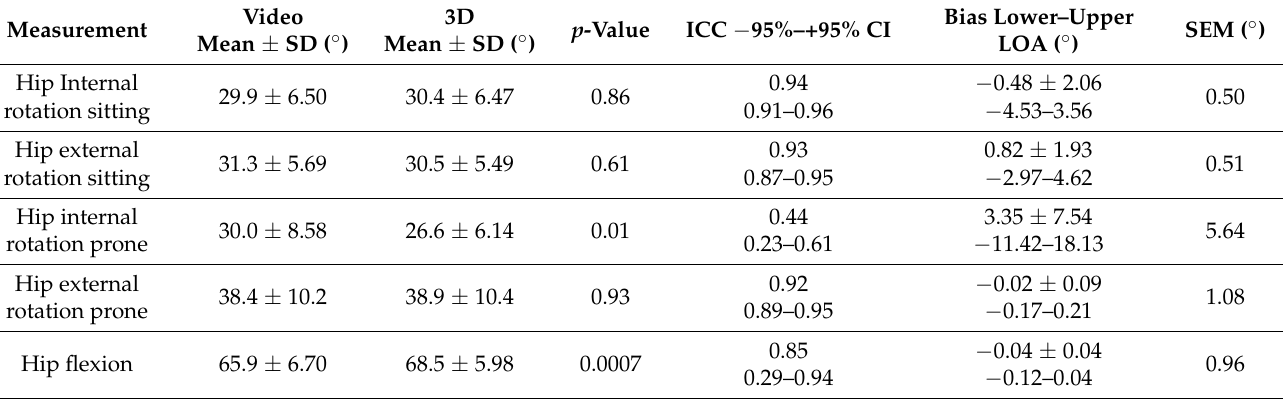
Table 2. Comparison of video measurements and gold-standard (3D analysis) measurements: means ± standard deviations, one way ANOVA p -value, ICC and 95% confidence intervals, Bland– Altman fixed bias and 95% LOA, and